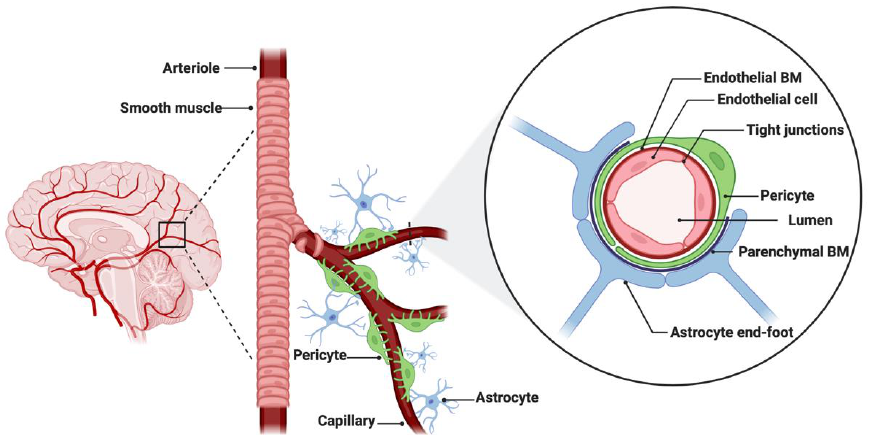
Figure 1. Anatomical features of the blood–brain barrier (BBB). The structure of the BBB in normal physiology consists of endothelial cells interconnected with a complex network of proteins (tight junctions), while mechanical support is provided by pericytes and astrocytic end-feet. The parenchymal and endothelial basal membranes (BM) provide additional strengthening to the cell attachments. Figure was created in BioRender.com (accessed on 5 July 2022).